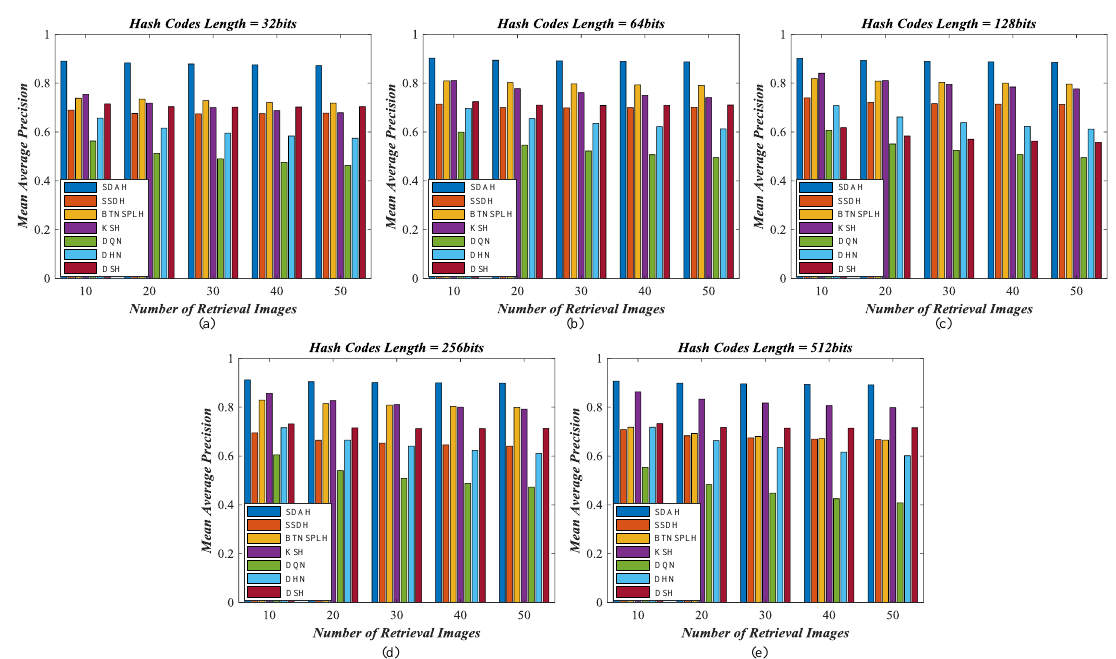
Figure 13. Mean average precision counted on different number of retrieval images using diverse hashing methods for NPWU archive: ( a ) the length of hash codes is 32 bits; ( b ) the length of hash codes is 64 bits; ( c ) the length of hash codes is 128 bits; ( d ) the length of hash codes is 256 bits; and ( e ) the length of hash codes is 512